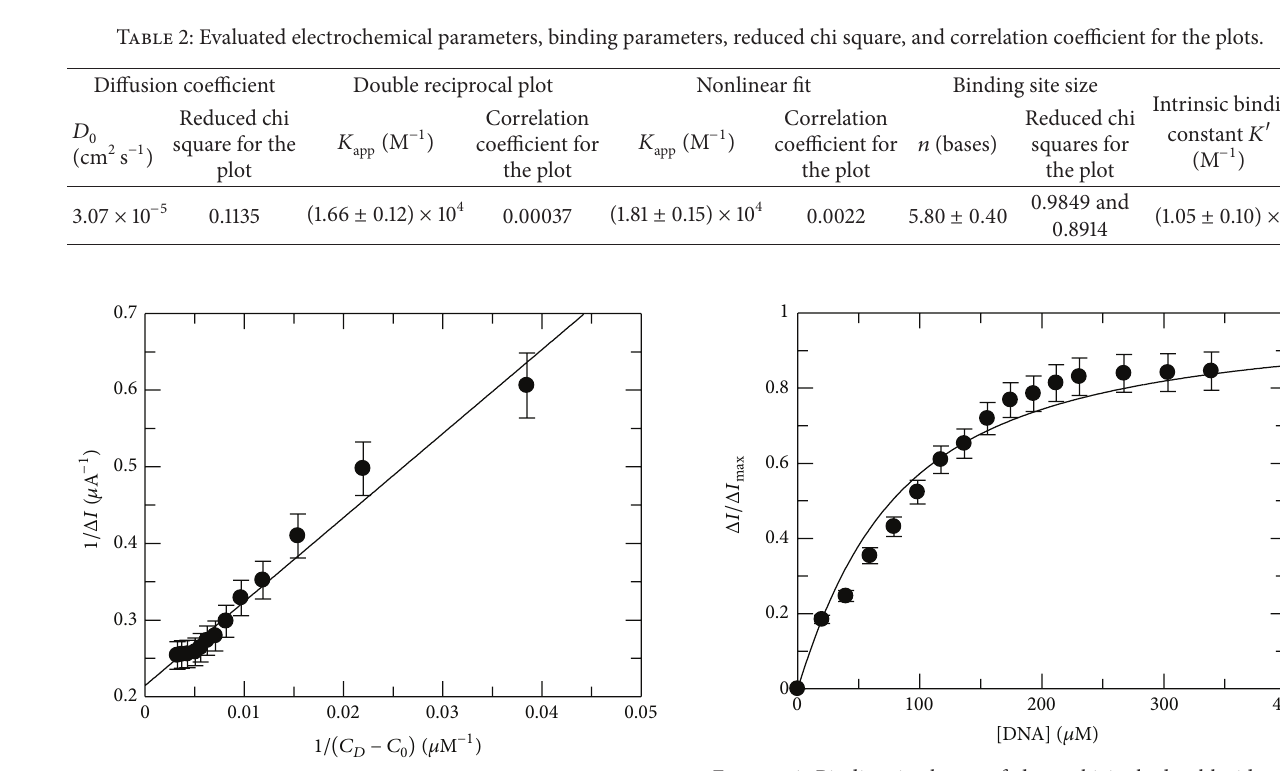
Figure 6: Binding isotherm of doxorubicin hydrochloride—CT DNA interaction and corresponding nonlinear fit using cyclic voltammetry; [doxorubicin hydrochloride] = 33 𝜇 M, pH = 7.4, [NaCl] = 0.160 M, and temperature = 25 ∘